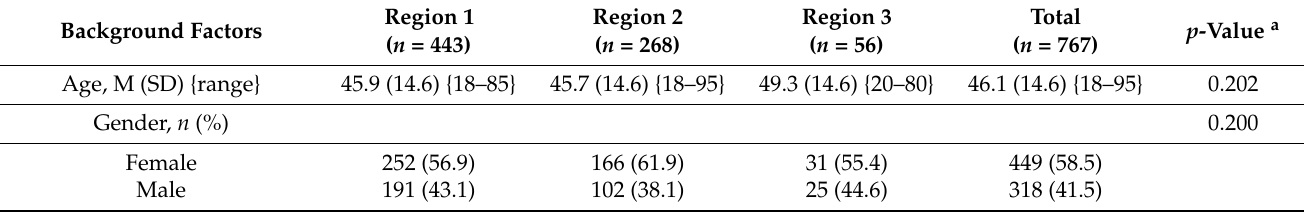
Table 1. Characteristics of the total sample grouped by